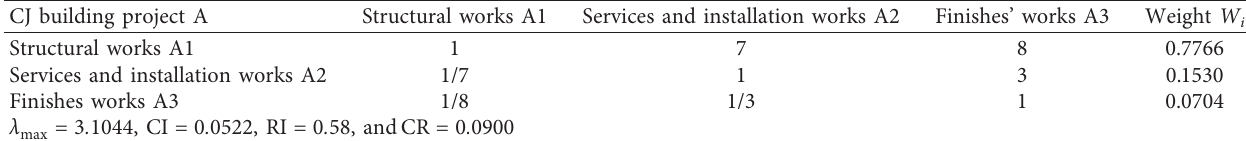
Table 4: Judgment matrix ( A ) and weight calculation of the CJ building construction project.